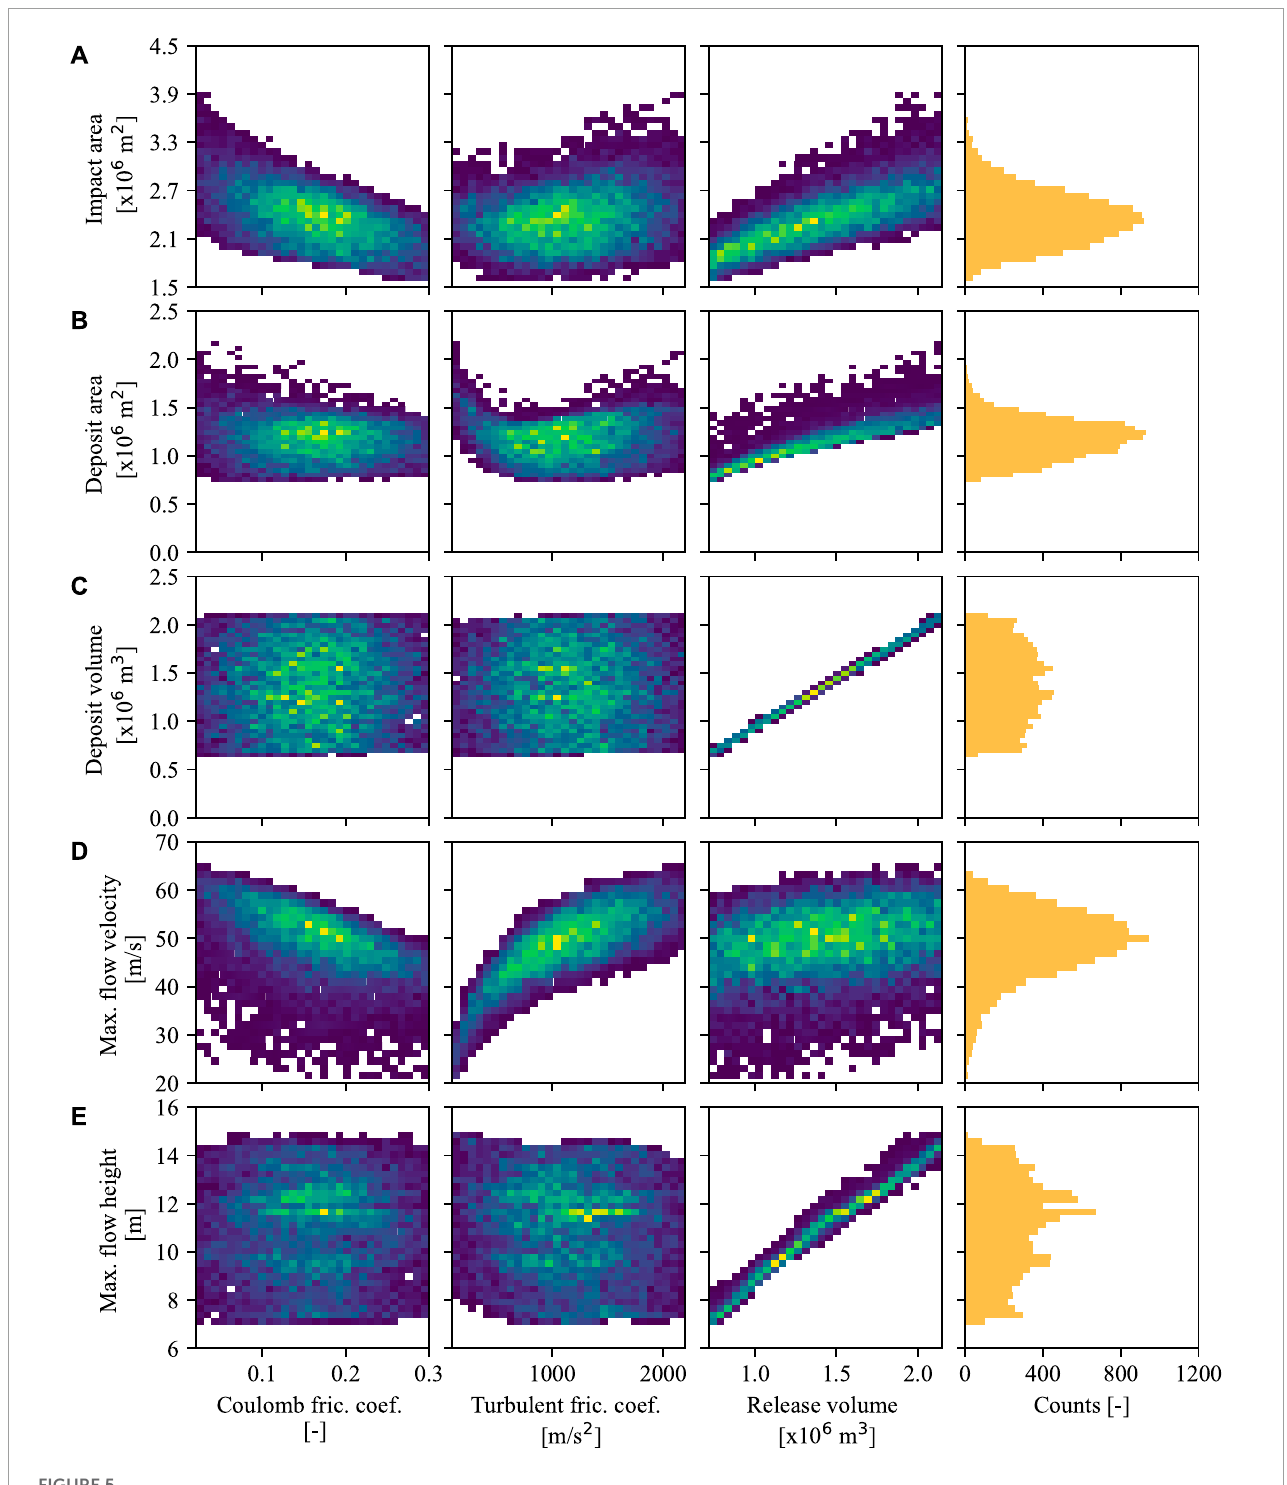
FIGURE 5 Relationships and histograms of (A) impact area, (B) deposit area, (C) deposit volume, (D) maximum flow velocity and (E) maximum flow height at ( x , y ) = (1000, 2000) from synthetic case with uncertain parameters used in the Monte Carlo analysis with coefficient of variation of 50%.